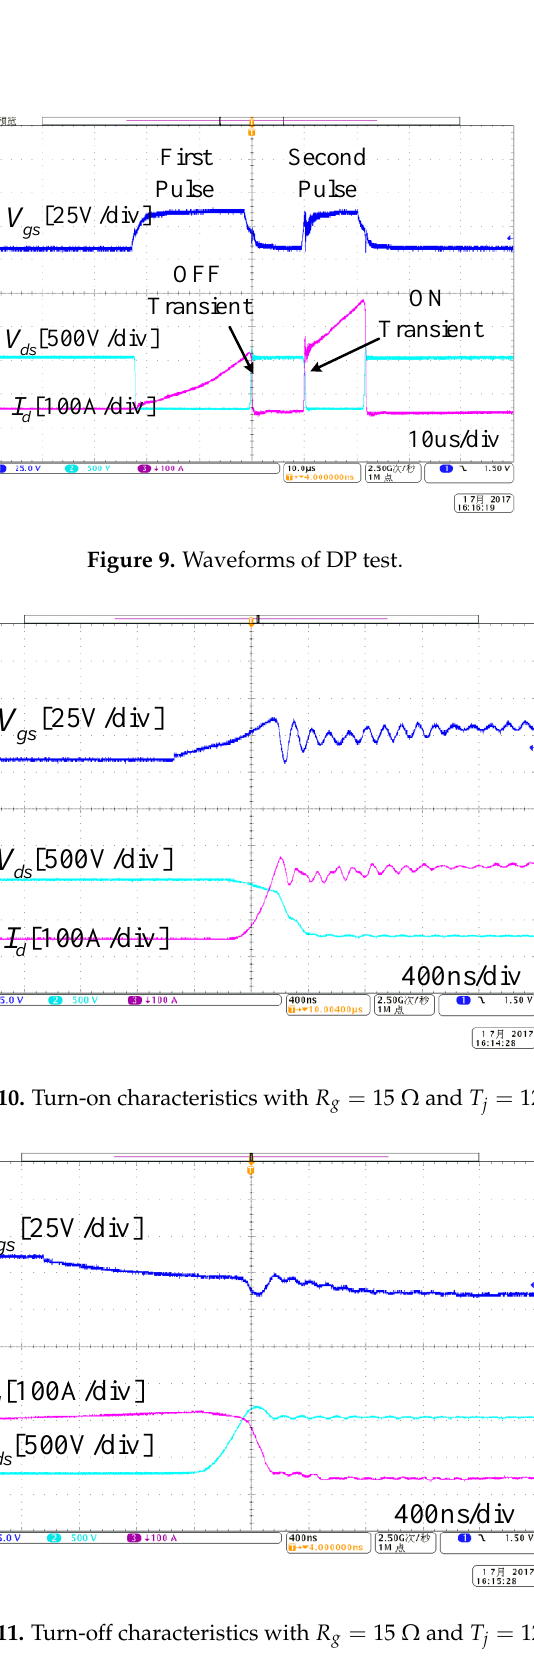
Figure 11. Turn-off characteristics with 𝑅 𝑔 = 15 Ω and 𝑇 𝑗 = 125 ℃ .